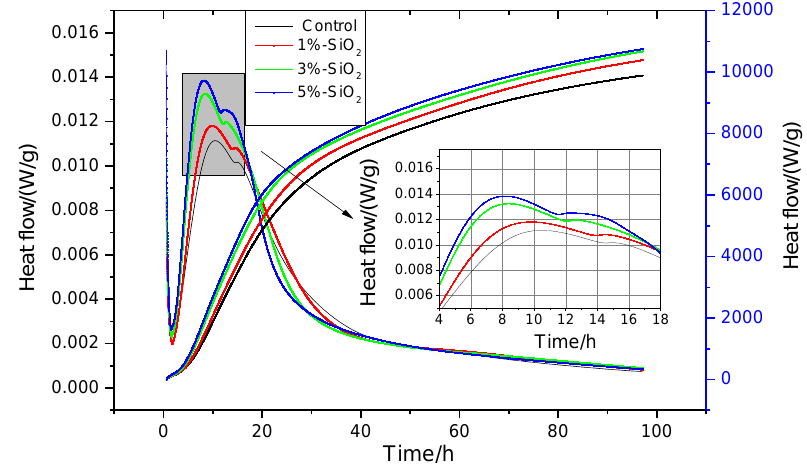
Figure 7. Effect of nano-SiO 2 on cement hydration exothermic rate and hydration heat.